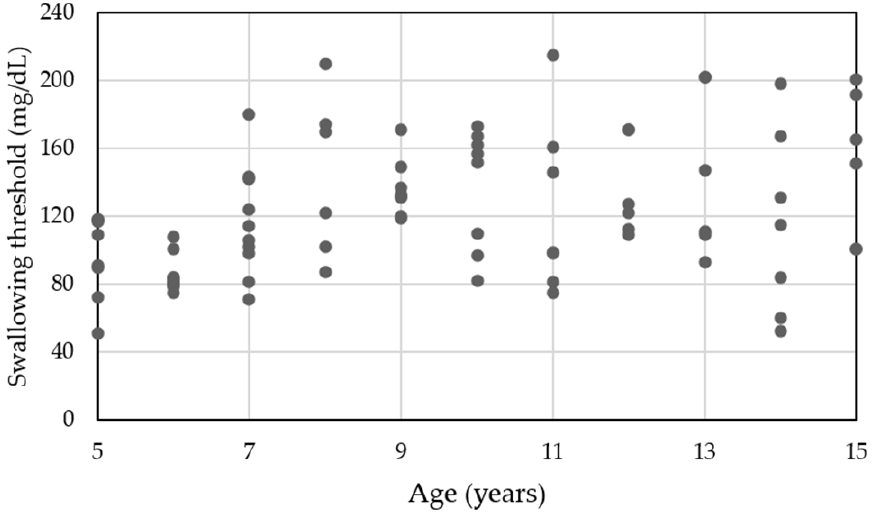
Figure 1. Correlation between age and swallowing threshold.